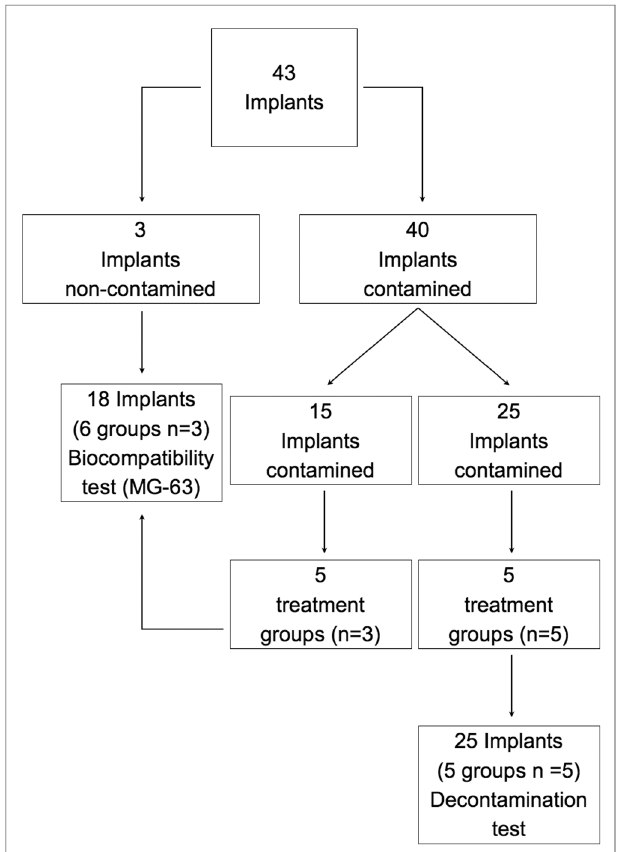
FIGURE 1 | Schematic representation of the distribution of the implants into the different groups and study sections. C, control group — no treatment; AW, air abrasion without powder, ESC, air abrasion with powder of erythritol, amorphous silica, and 0.3% chlorhexidine; HBX, sulfonic/sulfuric acid solution in gel alone; HBX+ESC, sulfonic/sulfuric acid solution in gel followed by air abrasion with powder of erythritol, amorphous silica, and 0.3%